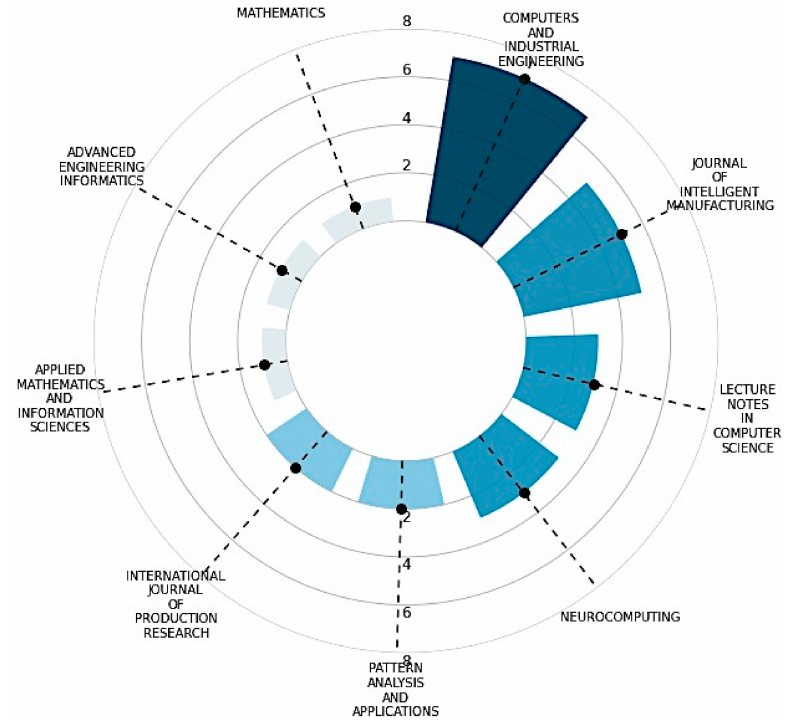
Figure 5. Journals in the